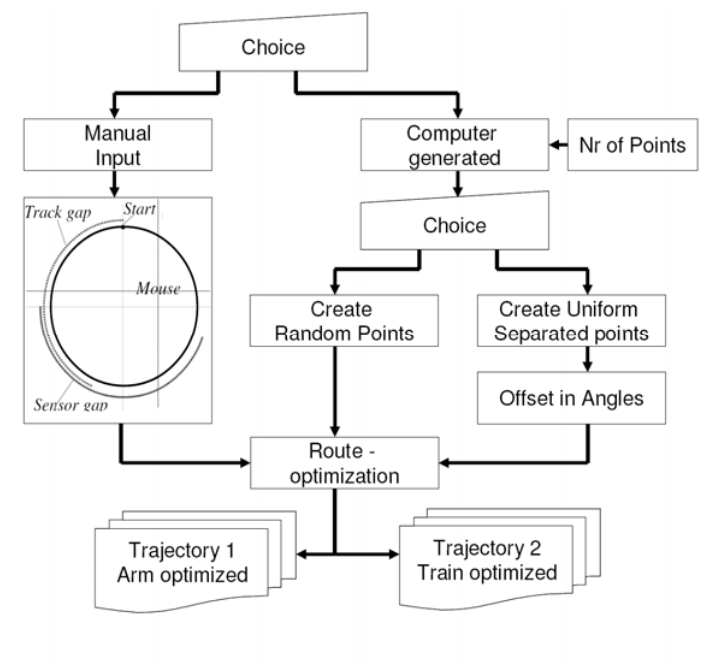
Figure 3. Flowchart of the Matlab Route-calculation